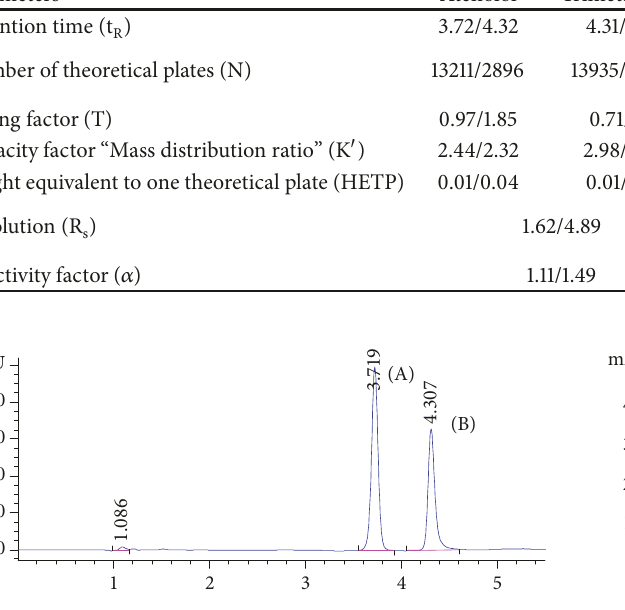
Figure 2: HPLC-PDA chromatogram of standard neat solution of